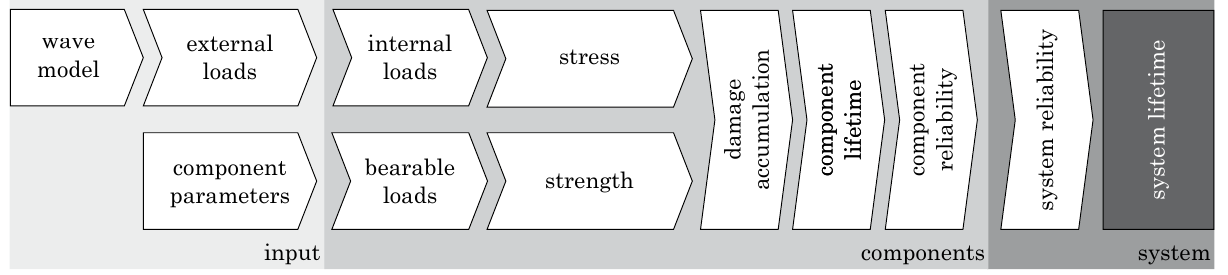
Figure 10: Reliability calculation approach (Neumann et al., 2016)